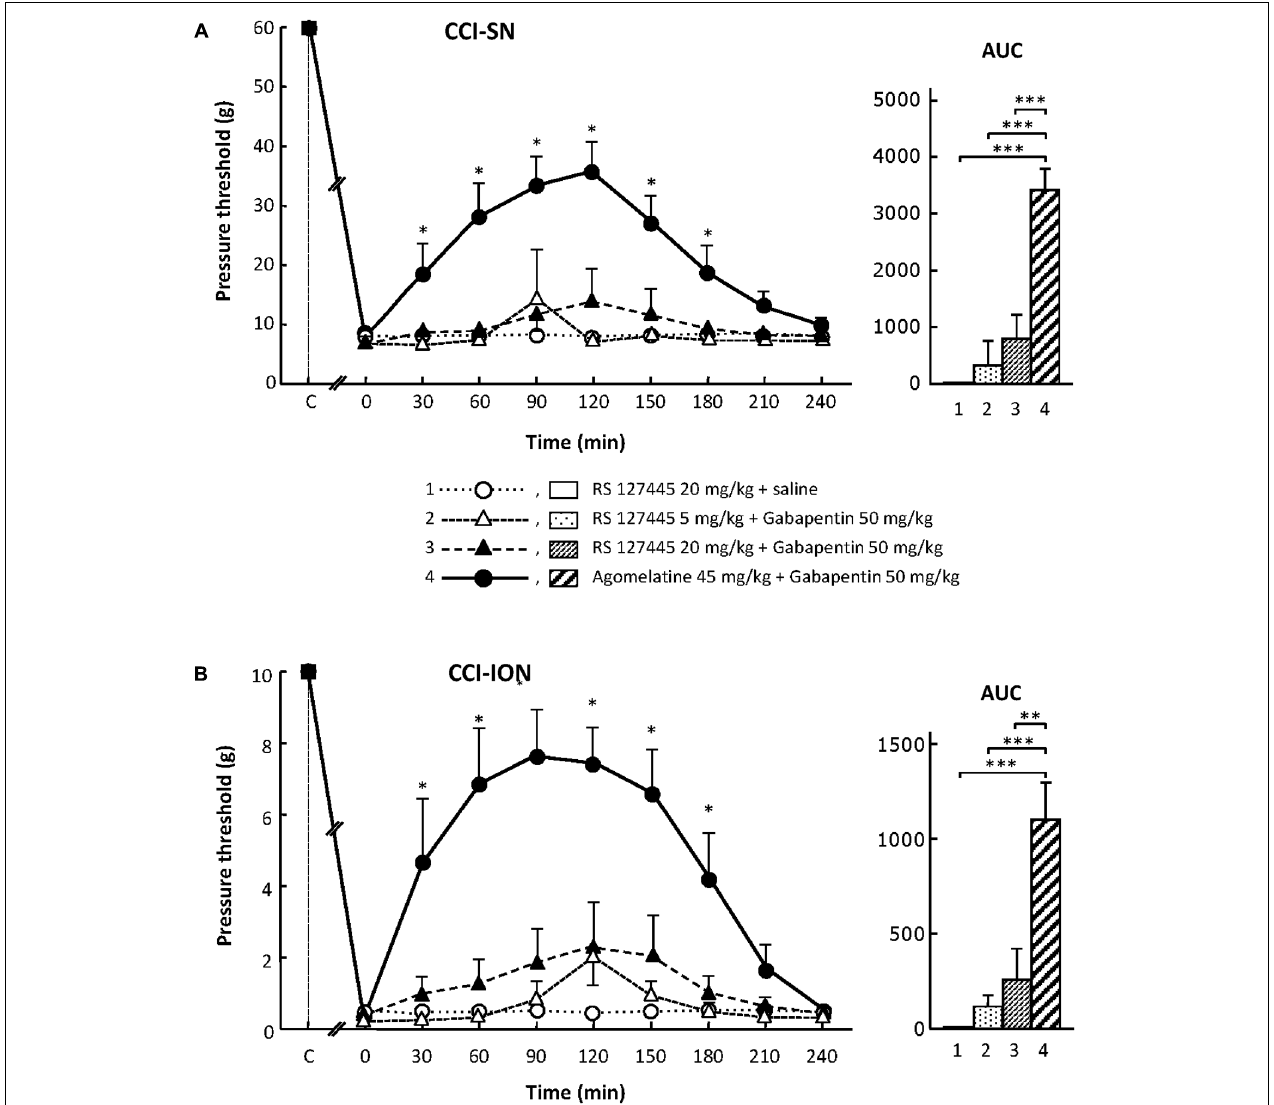
FIGURE 4 | Effects of RS 127445 alone or co-administered with gabapentin on mechanical allodynia in CCI-SN (A) and CCI-ION (B) rats. Comparison with the anti-allodynic effect of ‘agomelatine + gabapentin.’ Left panels: RS 127445 (20 mg/kg), RS 127445 (5 or 20 mg/kg) + gabapentin (50 mg/kg), agomelatine (45 mg/kg) + gabapentin and/or respective vehicles (saline, HEC; not shown) were injected i.p. 2 weeks after nerve ligation. Pressure threshold values (as g) were determined as described in the legend to Figure 1 . Each point is the mean ± SEM of n independent determinations. ∗ P < 0.05, compared with pressure threshold values determined just prior to drug injection (0 on abscissa), one way ANOVA with repeated measures, Dunnett’s test. C on abscissa: intact healthy rats before surgery. In both CCI-SN (A) and CCI-ION (B) rats, ‘saline+HEC’-treated groups were also included, but, for the sake of clarity, corresponding data are not represented as they superimposed with those obtained in rats treated with RS 127445 plus saline. Right panels : AUC values calculated from the respective time-course curves: (1) RS 127445 (20 mg/kg) + saline [ n = 6 (A) , n = 5 (B) ]; (2) RS 127445 (5 mg/kg) + gabapentin ( n = 6/7); (3) RS 127445 (20 mg/kg) + gabapentin ( n = 6/8); (4) agomelatine + gabapentin ( n = 7/7). A- CCI-SN : one way ANOVA [ F (3,21) = 25.20, P < 0.0001] followed by Tukey’s test ( ∗∗∗ P < 0.001); B- CCI-ION : one way ANOVA [ F (3,23) = 11.86, P < 0.0001] followed by Tukey’s test ( ∗∗ P < 0.01, ∗∗∗ P <